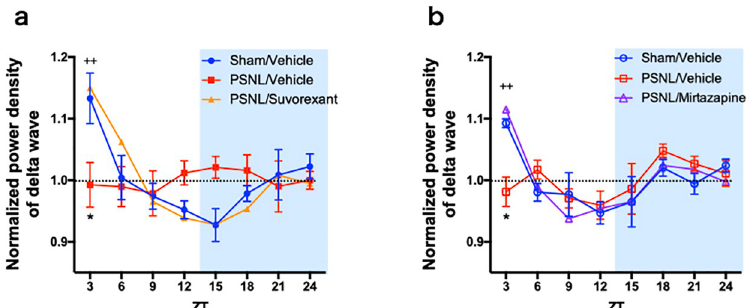
Fig 5. Influence of suvorexant or mirtazapine on the changes in power density of δ wave in PSNL mice. The change in the normalized power density of the δ wave in non-REM sleep was calculated every 3 h. Data are expressed as means ± SEMs (sham-vehicle, n = 5; PSNL-vehicle, n = 4–5; PSNL-suvorexant, n = 5; PSNL-mirtazapine, n = 5). � P < 0.05, compared between each sham-vehicle and PSNL-vehicle group, and ++ P < 0.01, compared between each PSNL-vehicle and PSNL-drug (suvorexant or mirtazapine) groups by two-way ANOVA with Bonferroni post-test. Abbreviations: ANOVA, analysis of variance; PSNL, partial sciatic nerve ligation; REM, rapid eye movement; SEM, standard error of the mean; ZT, Zeitgeber